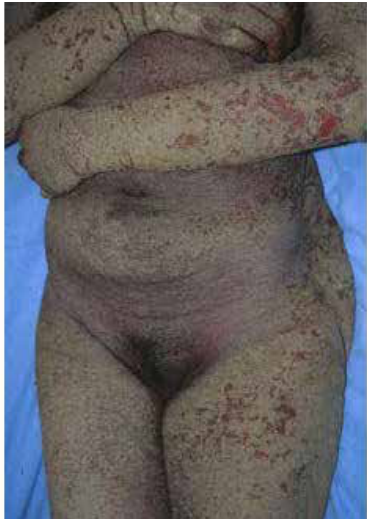
Figure 7. Extensive Norwegian scabies in advanced HIV